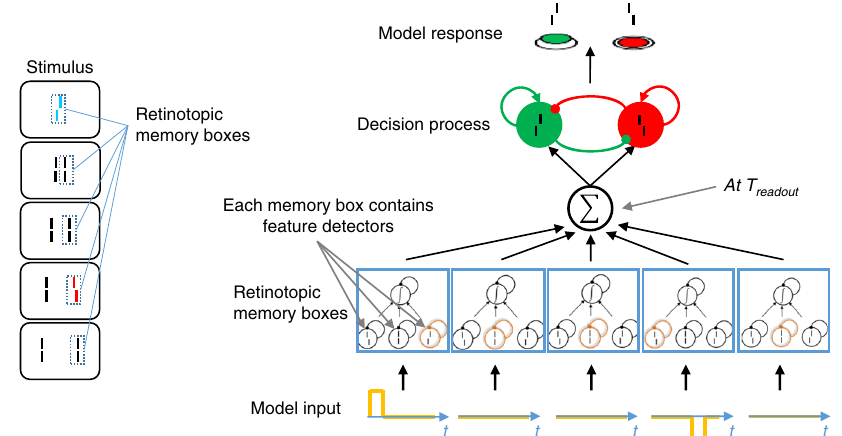
Fig. 5 Computational model. Left: At each retinal location there is a memory box, which is activated when a visual feature is presented at this location. Right: When a visual feature appears at a given location, the memory box opens and processes information about the corresponding visual feature, i.e., a vernier with either a right, a left, or an aligned offset. These feature detectors are modeled as leaky integrators. We represent pro-verniers as + 1, anti- verniers as − 1, and aligned lines as 0. Once stimulation at this retinal location terminates, the memory box closes, buffering the integrated information 21 . Thus, information about visual features at each location is preserved throughout the discrete integration window. This processing is “ unconscious ” . In this example, there are fi ve memory boxes, and the input to each of them is shown at the bottom. At the end of a discrete time window (denoted T readout ), the content of the different memory boxes is combined, yielding the output of stage 1. In the present case, the attended stream of elements is perceived as a single moving object, so the outputs of all memory boxes are summed. Stage 2 receives the outputs of stage 1 and drives the decision. The task is to report vernier offset directions, which we implement using a biologically plausible decision making network proposed by Wong & Wang 22 . Details of the discrete computational model are provided in the A long lasting period of integration is well in line with previous fi ndings showing postdictive effects for several hundreds of mil-